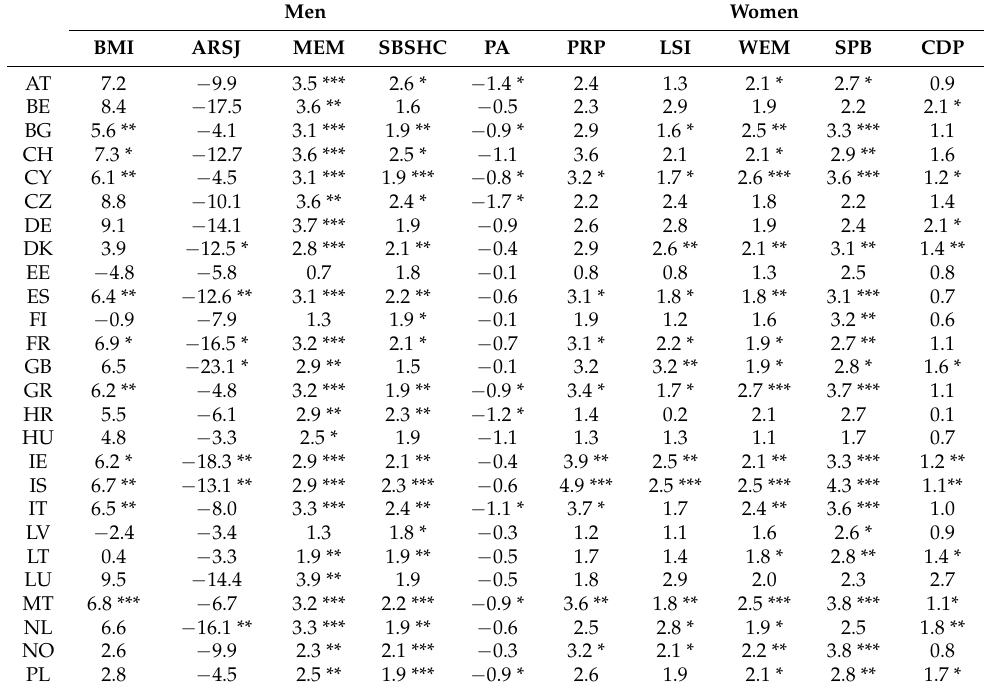
Table 4. Local values of the GWR coefficients for men’s and women’s absence rate from work due to own illness or